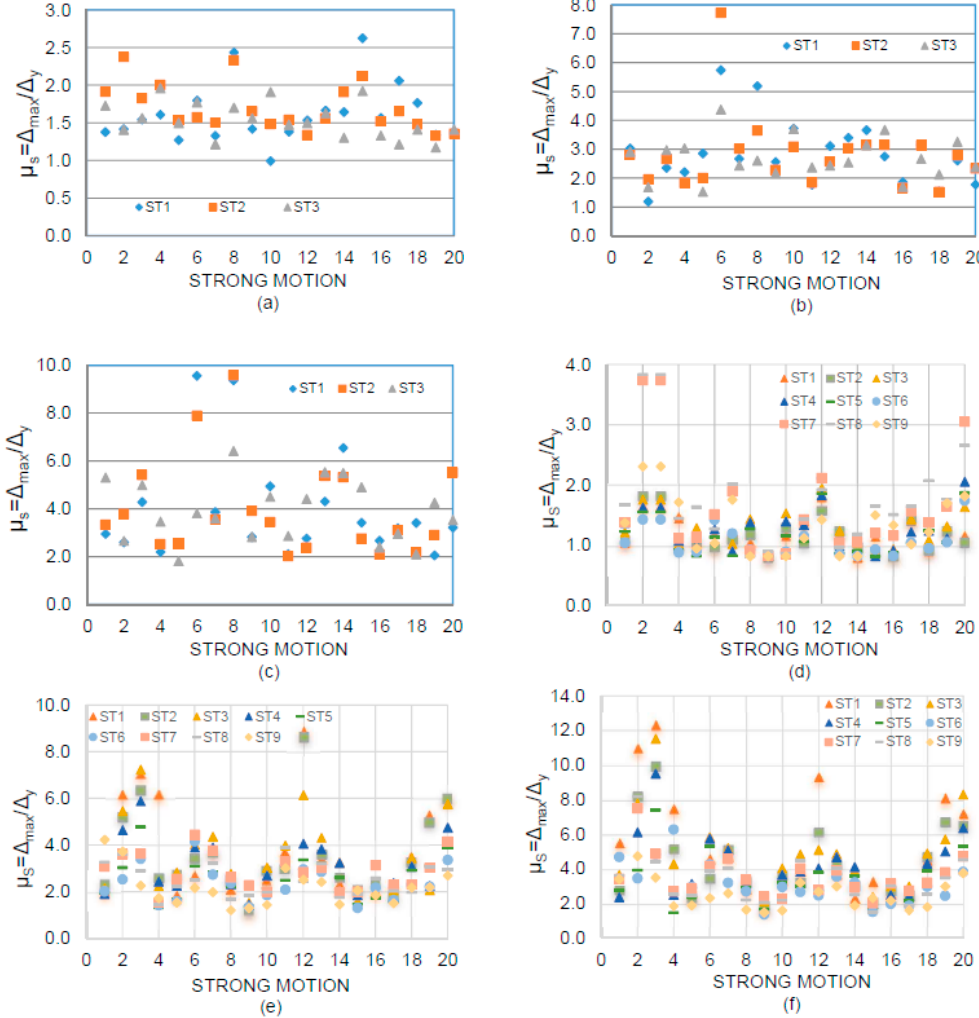
Figure 5. Story ductility ( μ S ) values; NS direction; 3 ‐ level building: ( a ) S a = 0.4 g, ( b ) S a = 0.8 g, ( c ) S a =